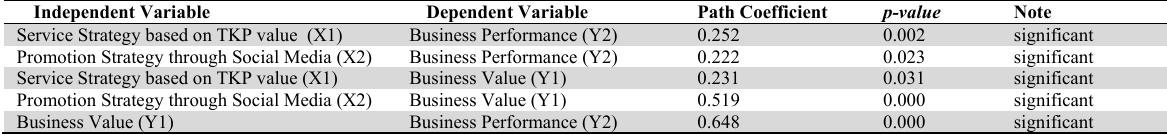
The Results of Hypothesis Direct Effect